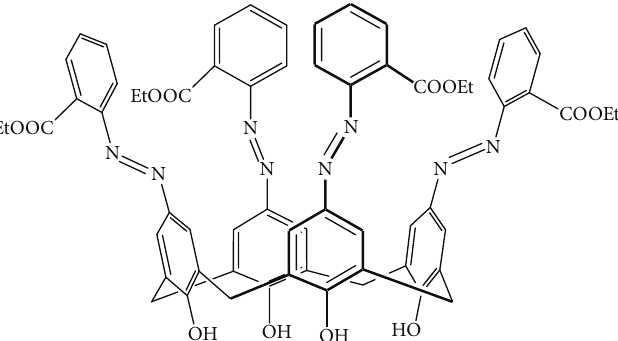
Figure 1: Structure of 5,11,17,23-tetra[(2-ethyl acetoethoxyphenyl)(azo)phenyl]calix [4]